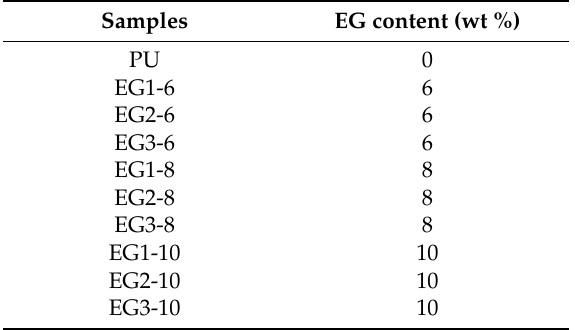
Table 1. The formulae of rigid polyurethane foams samples